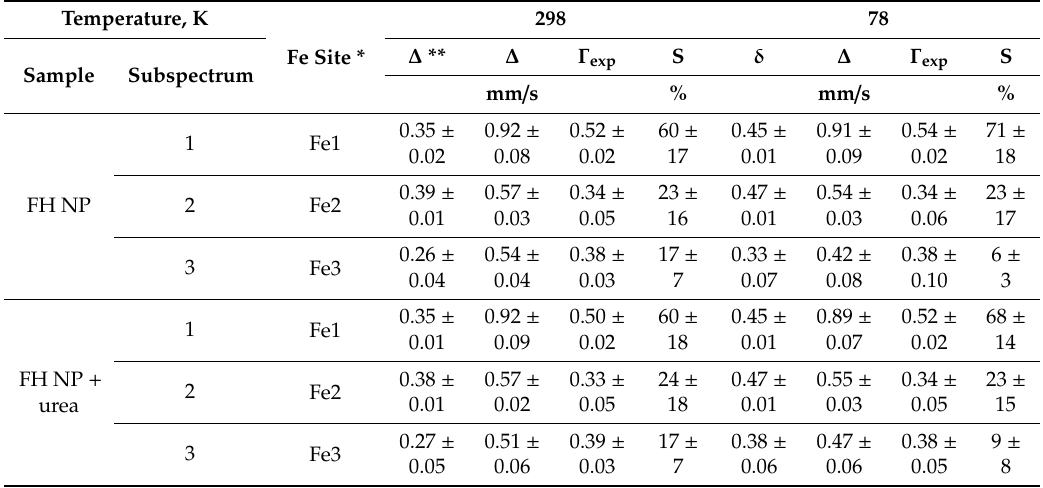
Table 1. The Mössbauer spectroscopy data for the ferrihydrite (FH) nanoparticles in the absence and presence of urea recorded at 298 K and 78 K. Temperature, K